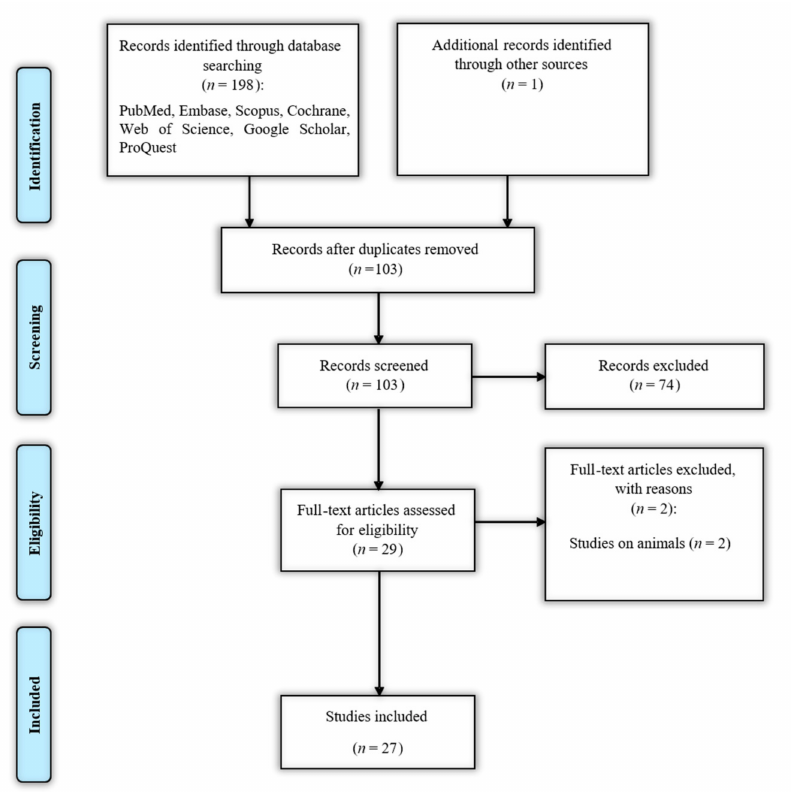
Figure 1. Search strategy flow chart based on the Preferred Reporting Items for Systematic Reviews and Meta-Analyses (PRISMA) flow